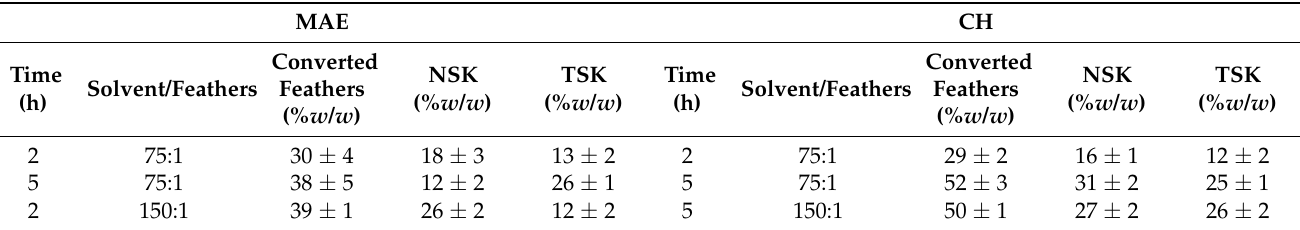
Table 1. Converted feathers, NSK and TSK yields % w / w respect to initial feathers, obtained in the various experimental conditions explored. The results are expressed as average ± standard deviation ( N = 3